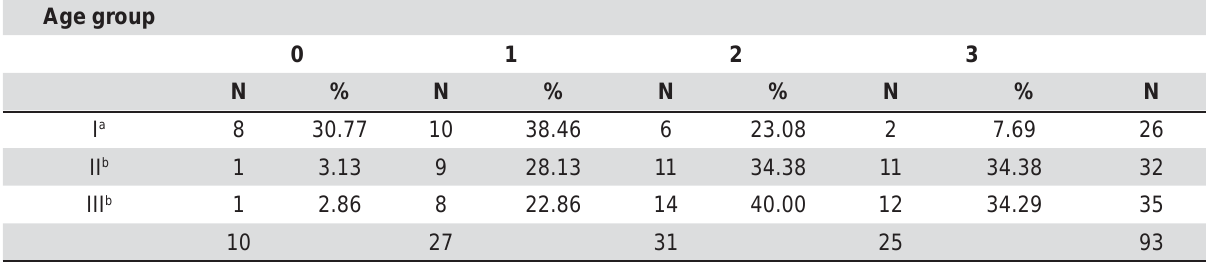
Table 1- Distribution of the different degrees of acinar autolysis according to the age group Age group 0 1